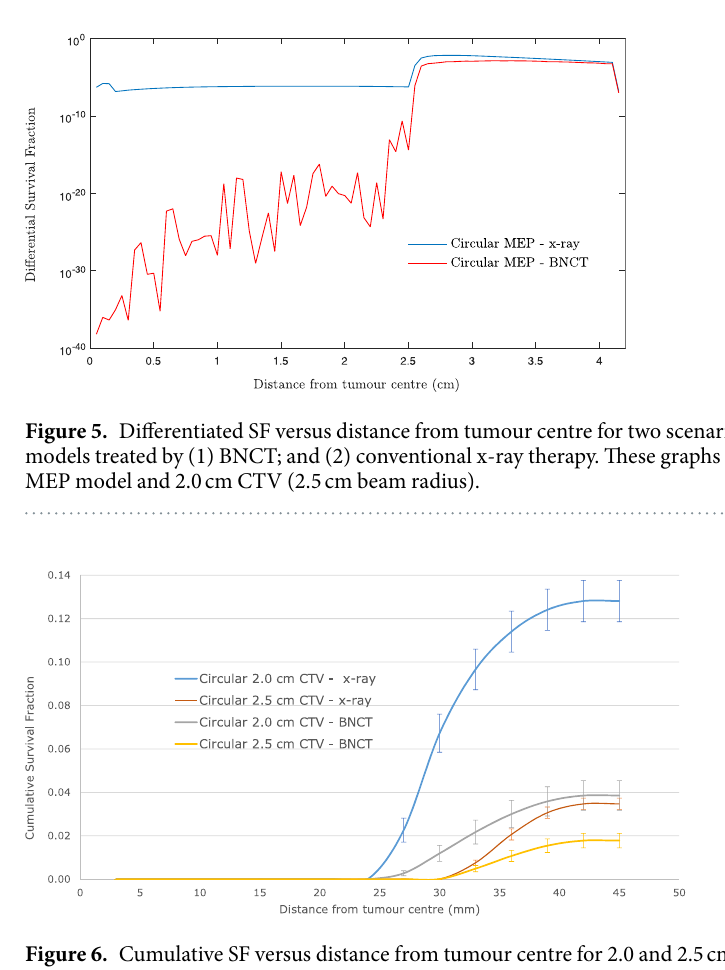
Figure 6. Cumulative SF versus distance from tumour centre for 2.0 and 2.5 cm CTVs applying the circular microscopic extension distribution model for a homogeneous-hypoxic GBM treated by BNCT as compared to conventional x-ray